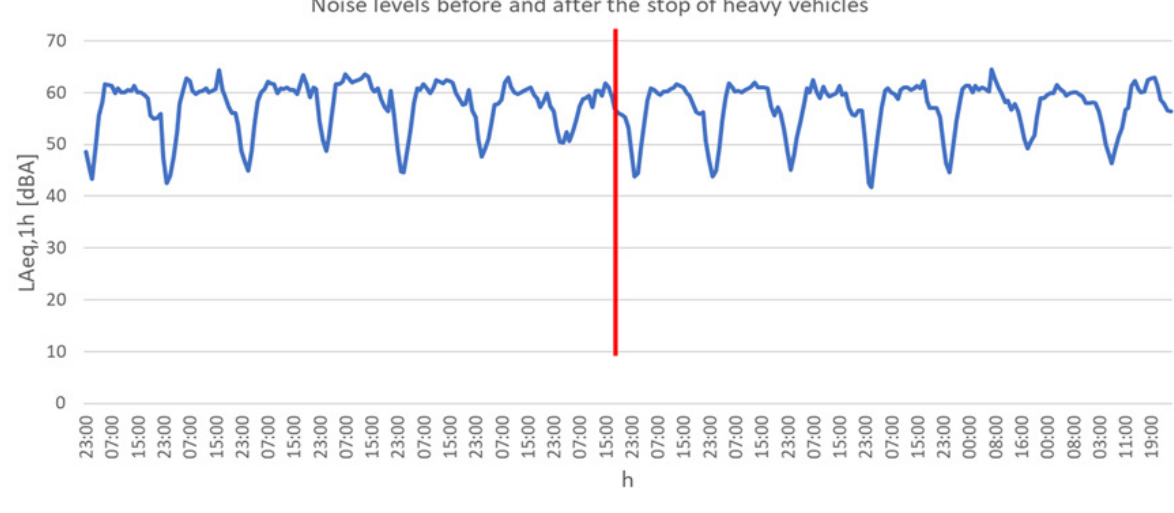
Figure 8: Noise levels recorded by the sensor HC101 before and after the stop of heavy